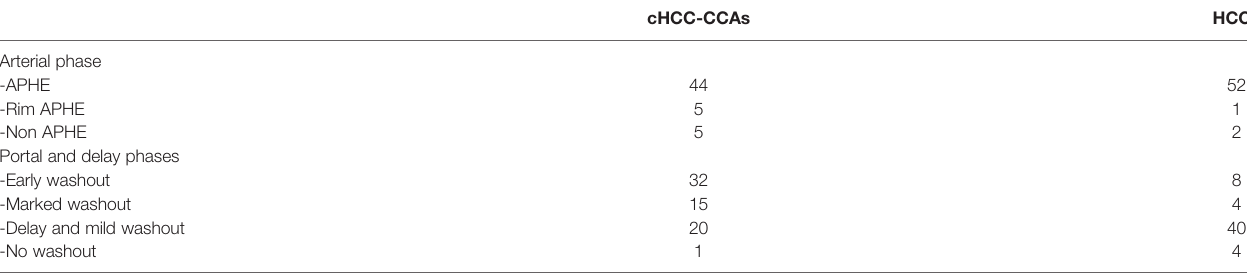
TABLE 2 | Contrast enhancement patterns of cHCC-CCAs and HCCs on CEUS.